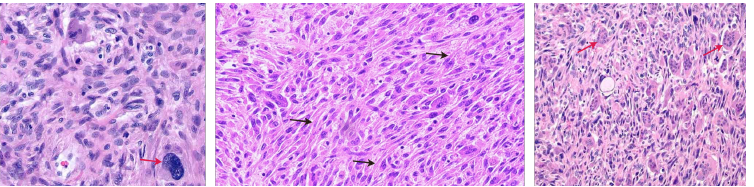
Figure 1. Histopathologic findings of UCOGCs showing undifferentiated cells with osteoclast-like giant cells (red arrows) and spindle-shaped cells (black